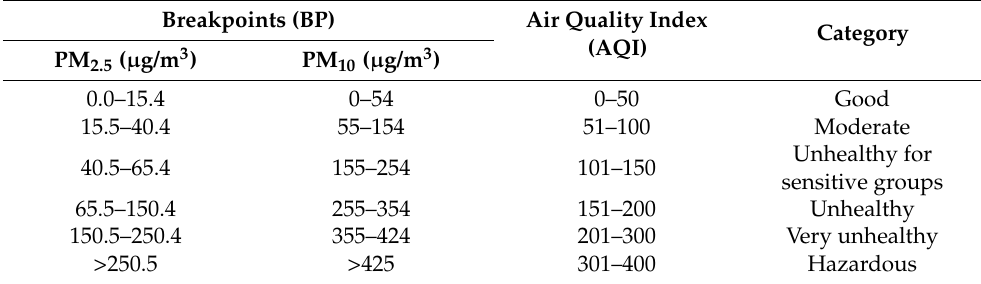
Table 2. Breakpoints (BP) for the AQI parameters.